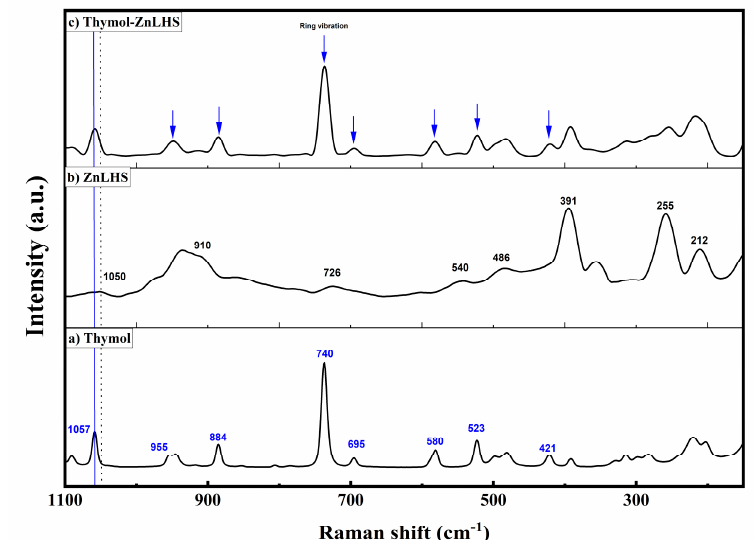
Figure 4. Fourier-transform infrared spectroscopy: ( a ) IR spectra of thymol and zinc layered hydrox- ide with and without thymol and ( b ) second derivative spectra of the analyzed samples in the 1500– 600 cm − 1 region; significant peaks were considered at p < 0.05 and represented by *.